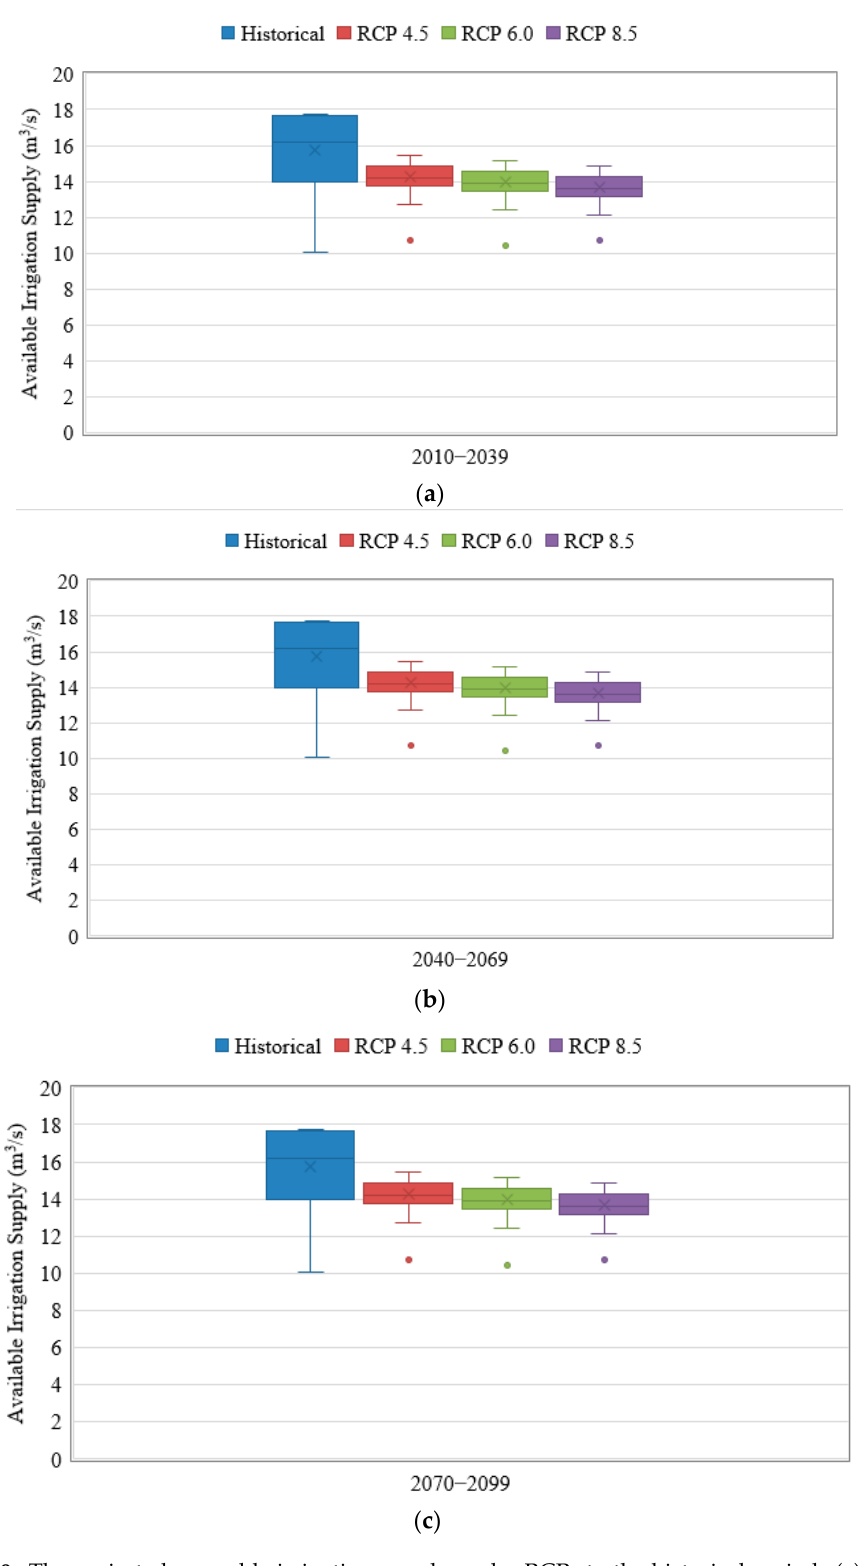
Figure 9. The projected ensemble irrigation supply under RCPs to the historical period: ( a ) 2020s, ( b ) 2050s, and ( c ) 2080s.